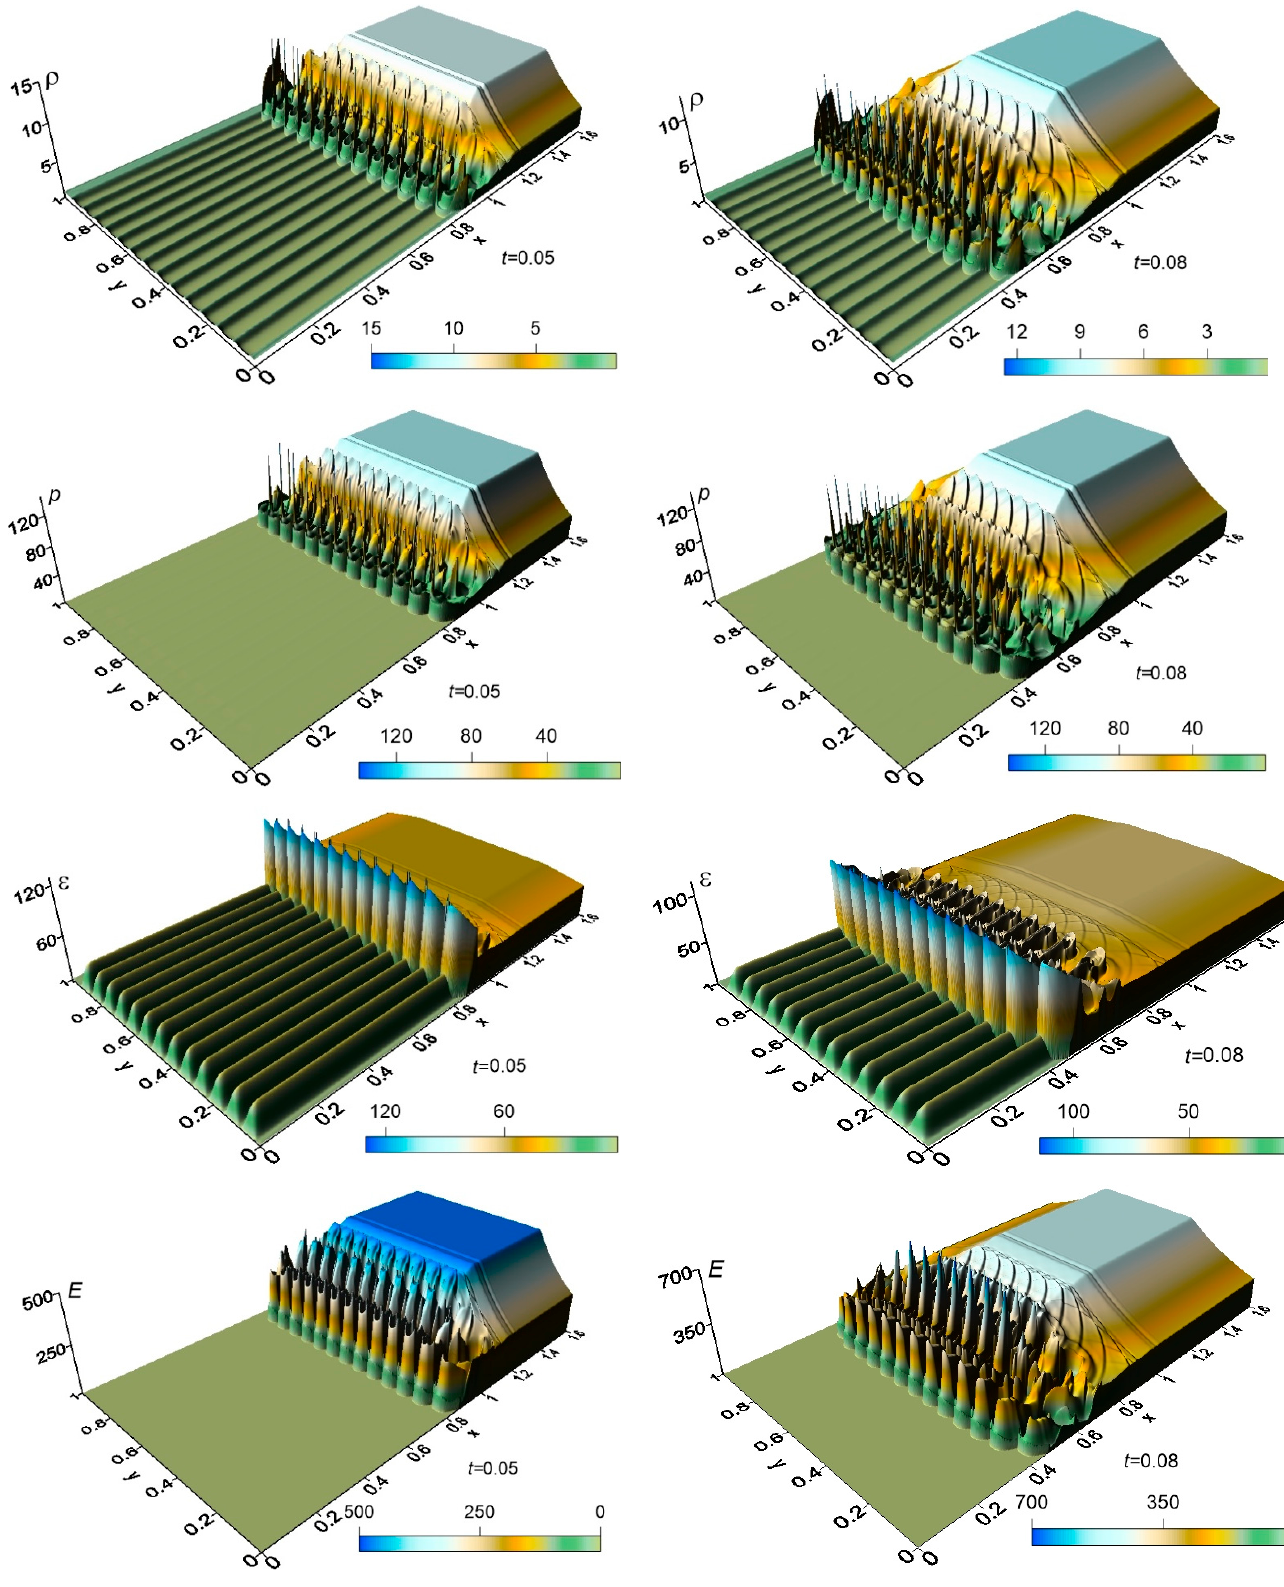
Figure 5. Dynamics of the considered parameters ( ρ , p , ε and E ): M = 10, α = 0.1.